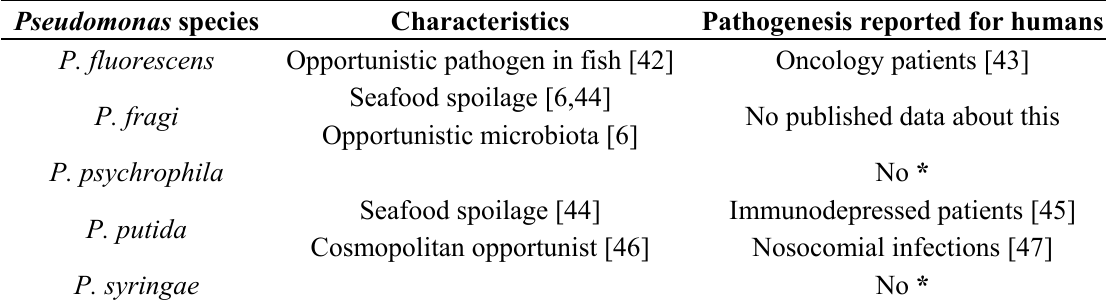
Table 2. Characteristics of the Pseudomonas species found from commercial Amazonian fish and potential risk for